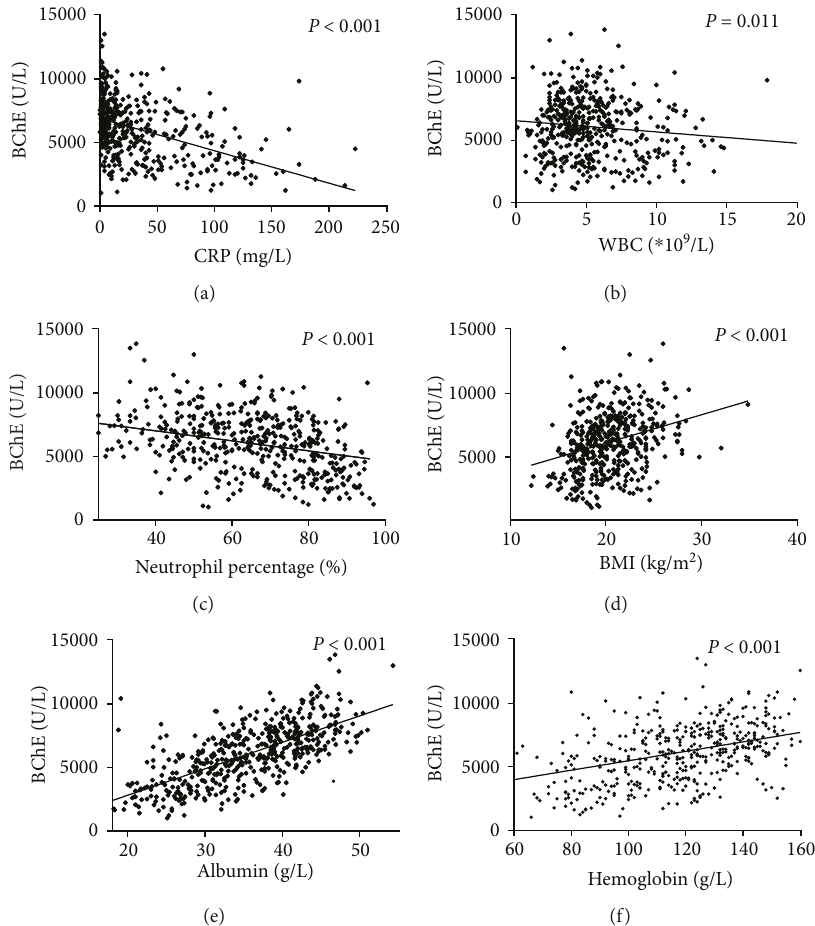
Figure 3: BChE, infection, and nutrition. BChE levels decrease signi fi cantly with increasing CRP levels, WBC, and neutrophil proportion ( P < 0 001 , P = 0 011 , and P < 0 001 , resp.) (a – c). BChE levels are positively associated with body mass index, albumin, and hemoglobin (all P < 0 001 ) (d –